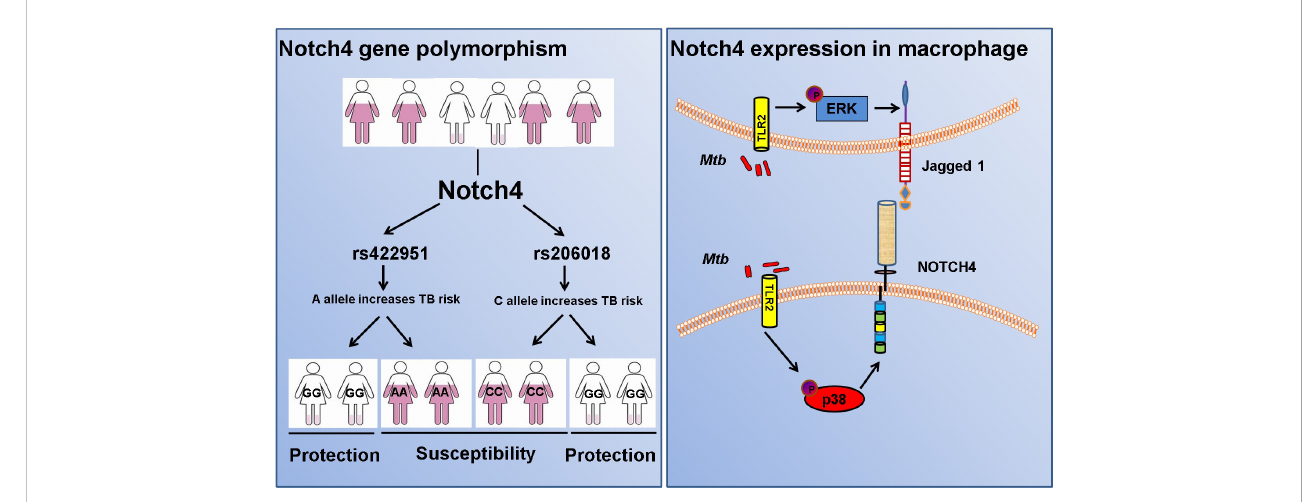
FIGURE 7 Diagram of Notch4 polymorphisms and gene